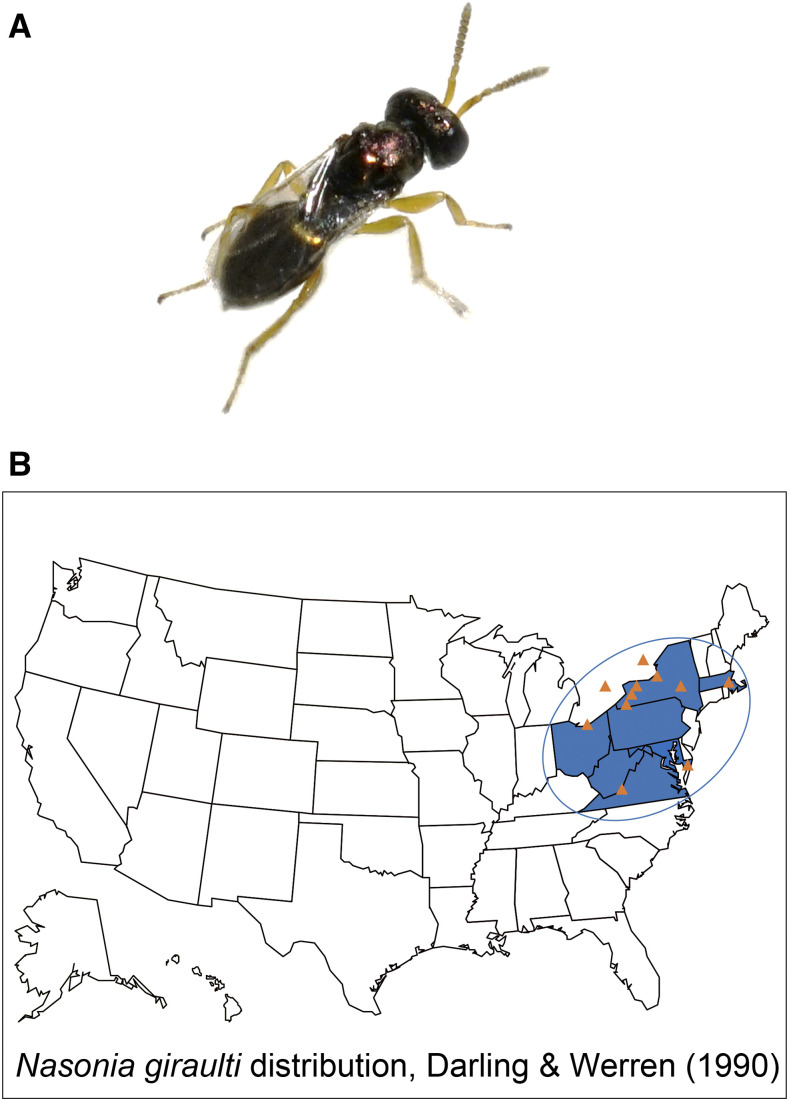
Image of N. giraulti and its geographic distribution in the North America based on Darling & Werren (1990).